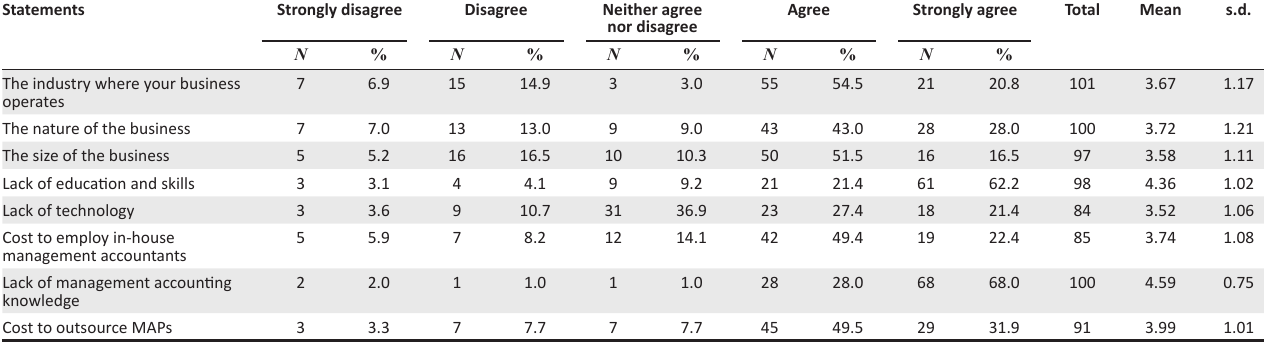
TABLE 6: Factors affecting the respondents’ use of management accounting